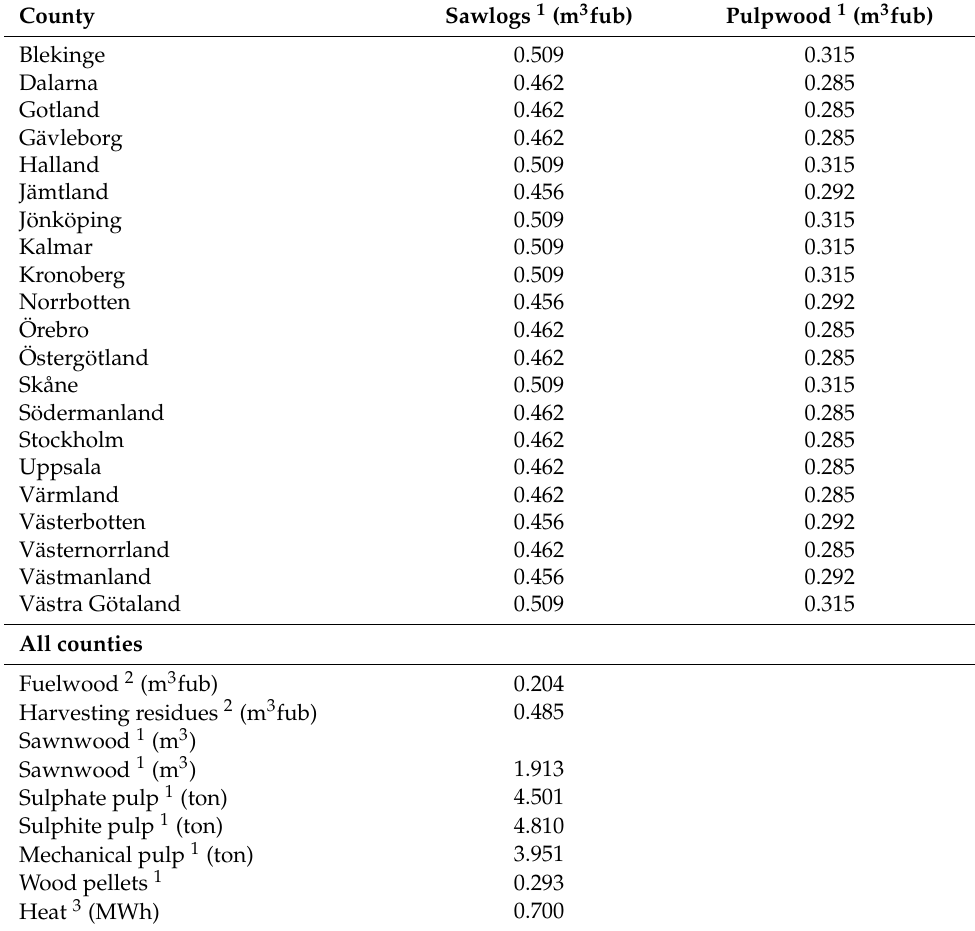
Table A5. Average prices 2008–2014 in 1000 SEK.